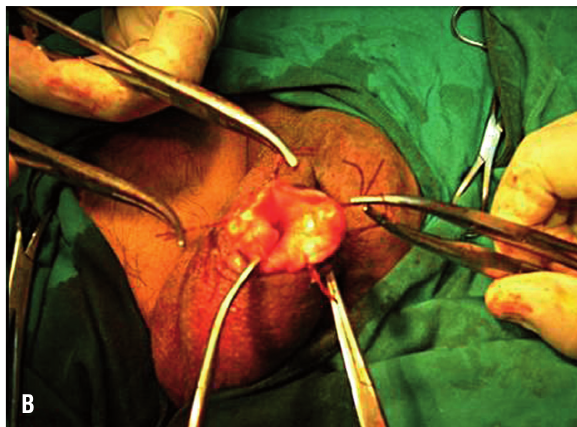
Figure 3A - An operative photograph showing the beginning of the eversion technique. Blue arrow points to the visceral tunica vaginalis while the black one points to the parietal tunica.